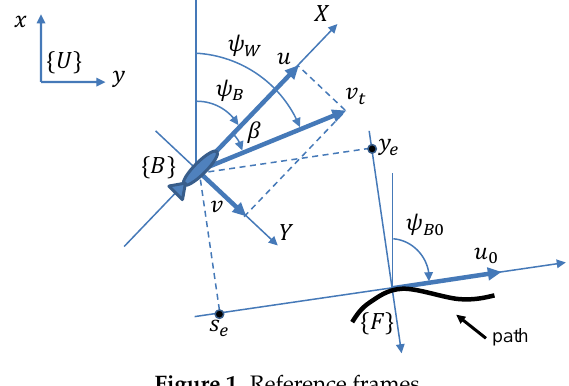
Figure 1. Reference